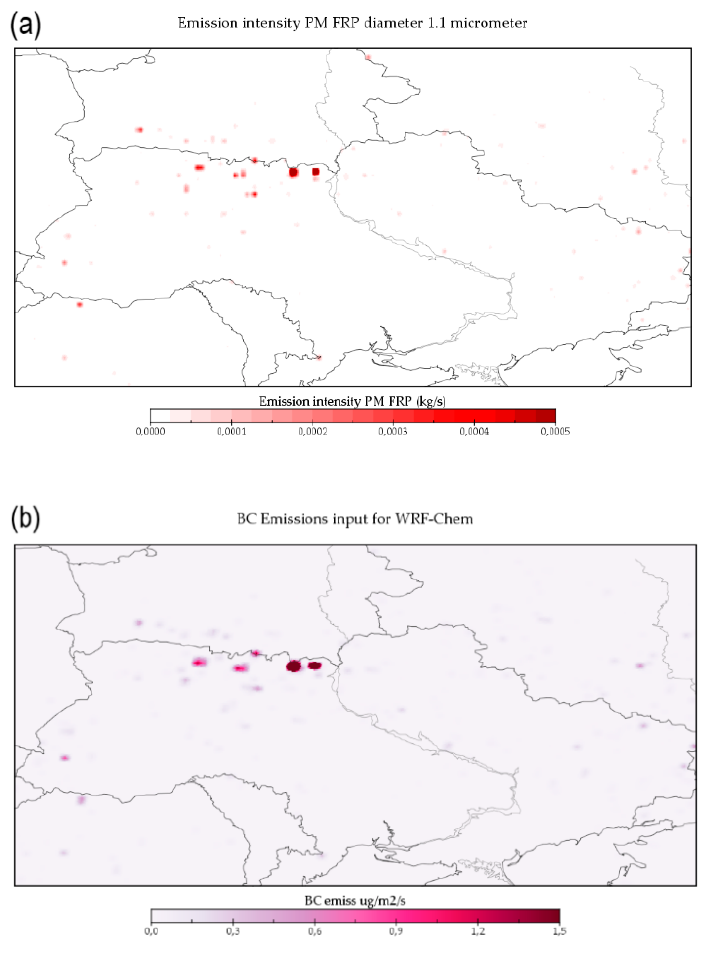
Figure 1. ( a ) Emission intensity of particulate matter (PM) in kg/second per grid with nominal diameter of 1.1 µm derived from the IS4FIRE project; ( b ) Black Carbon (BC) emissions ready to be used as input for the WRF-Chem simulation for the 8 April 2020.